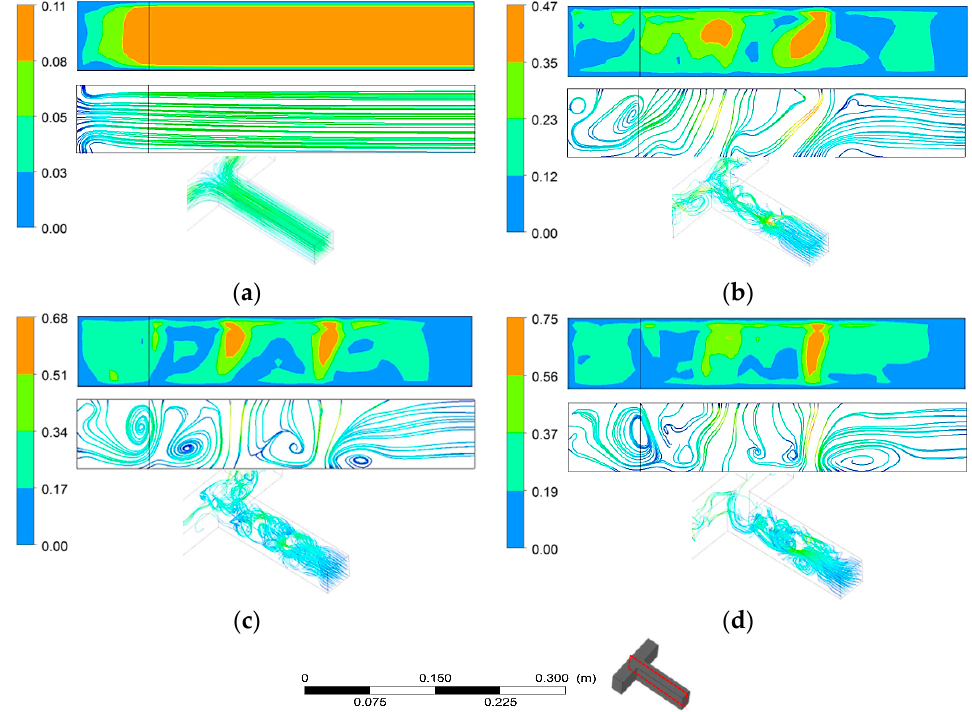
Figure 11. Flow field in the melt: ( a ) conventional process; ( b ) 100 A; ( c ) 150 A; ( d ) 200 A (unit: m/s).